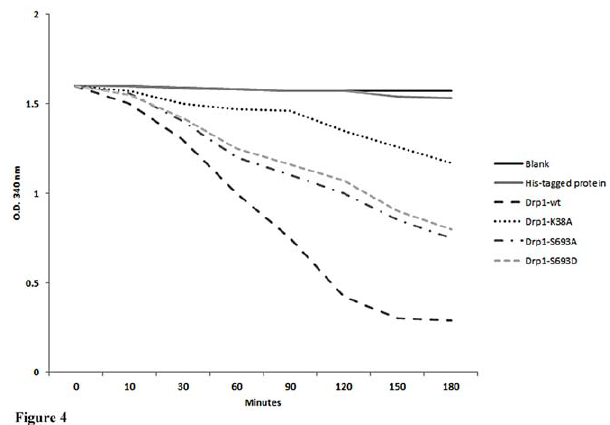
Figure 4. GTPase hydrolysis activity of Drp1mutants. A GTPase hydrolysis activity assay was performed followed the procedures published by Ingerman and Nunnari [41]. E. coli were transformed by Drp1 mutant plasmids and 15 m g of cell lysate was applied to the assay. O.D. 340 was measured to reflect the constant of the NADH. The slope reflects the consumption of NADH. The data are representative of three independent experiments and are shown as mean values 6 SD.